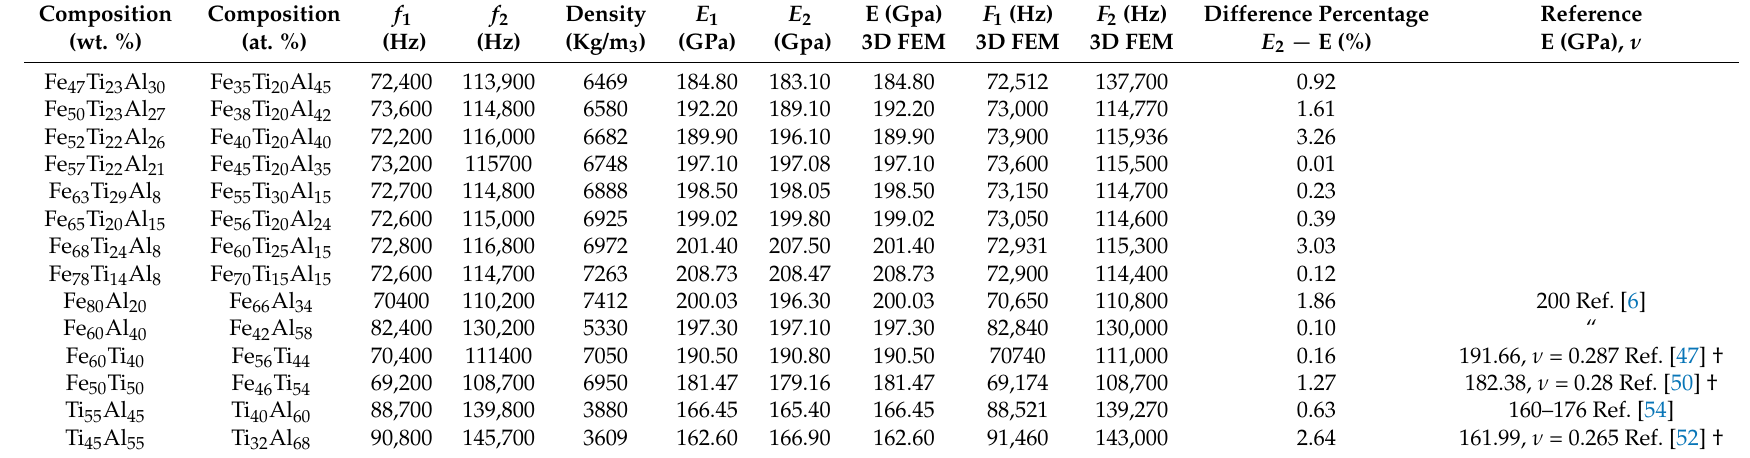
Table 4. The resonance frequencies ( f 1 , f 2 ) recovered from the vibration spectra obtained using the shear wave transducers and the corresponding Young’s moduli ( E 1 , E 2 ) retrieved using Equation (2). The final 3D FEM Young’s moduli ( E ) after adjustment to fit experimental resonance frequencies. The difference between E 2 and E is given in percentage. The † indicate ab initio calculated results found in the literature. The values of K 1 = 4.6356, K 2 = 7.3284, and the initial ν =